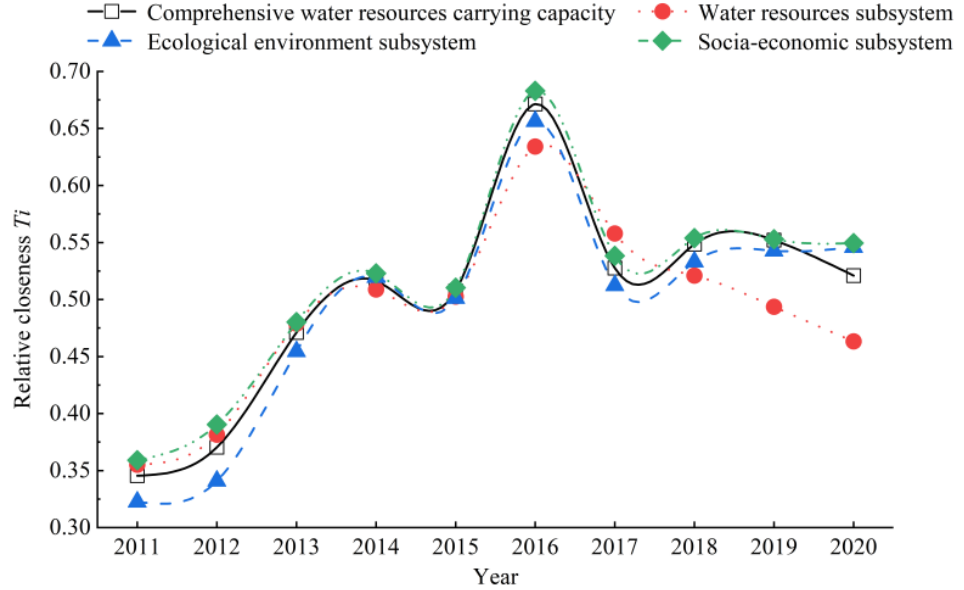
Figure 3. The comprehensive WRCC of Shihezi from 2010 to 2020 and the evaluation results of the carrying capacity of each subsystem.